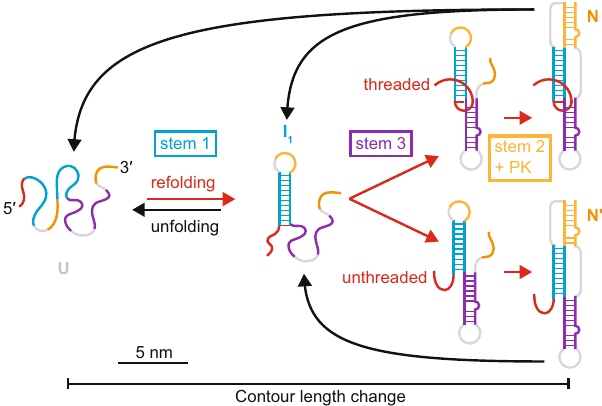
Fig. 5 Pseudoknot folding and unfolding pathways. Schematic of pathways for folding (red) and unfolding (black) the pseudoknotted conformers. Stem 1 forms fi rst, then stem 3, with a bifurcation leading to 5 ′ - threaded (top) or -unthreaded (bottom) conformers depending on orientation of 5 ′ end just before stem 2 forms. RNA segments are colored corresponding to their participation in native secondary structure elements as in Fig.